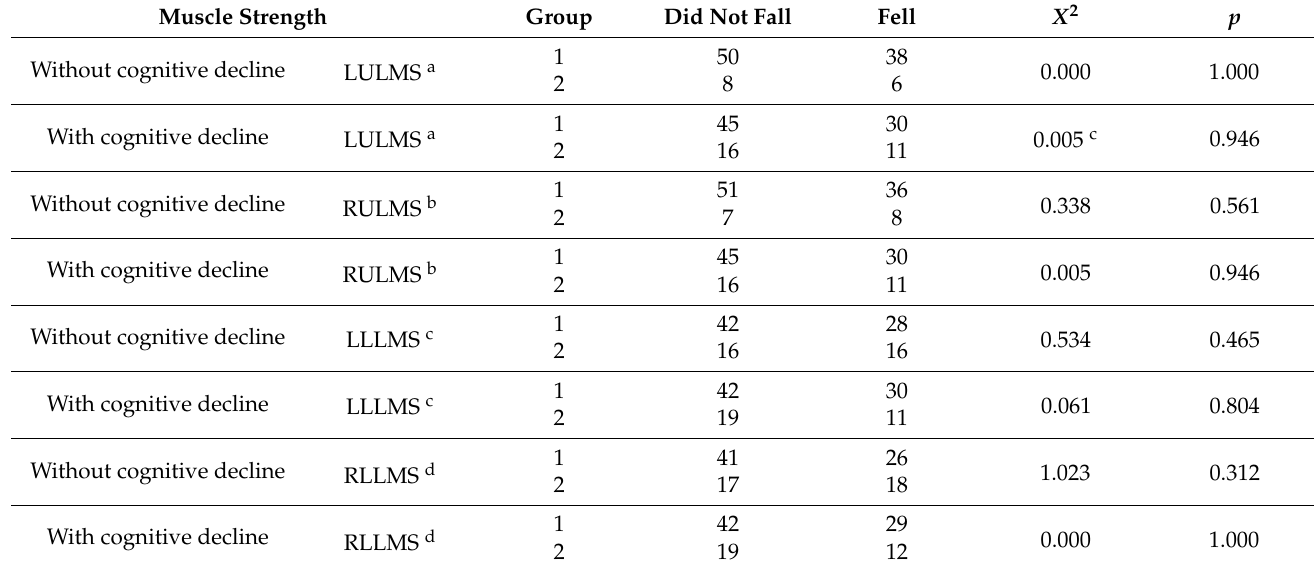
Table 3. Results of application of the chi-square test among muscle strength, falls throughout the year, and muscle strength, according to the cognitive status of the older persons.